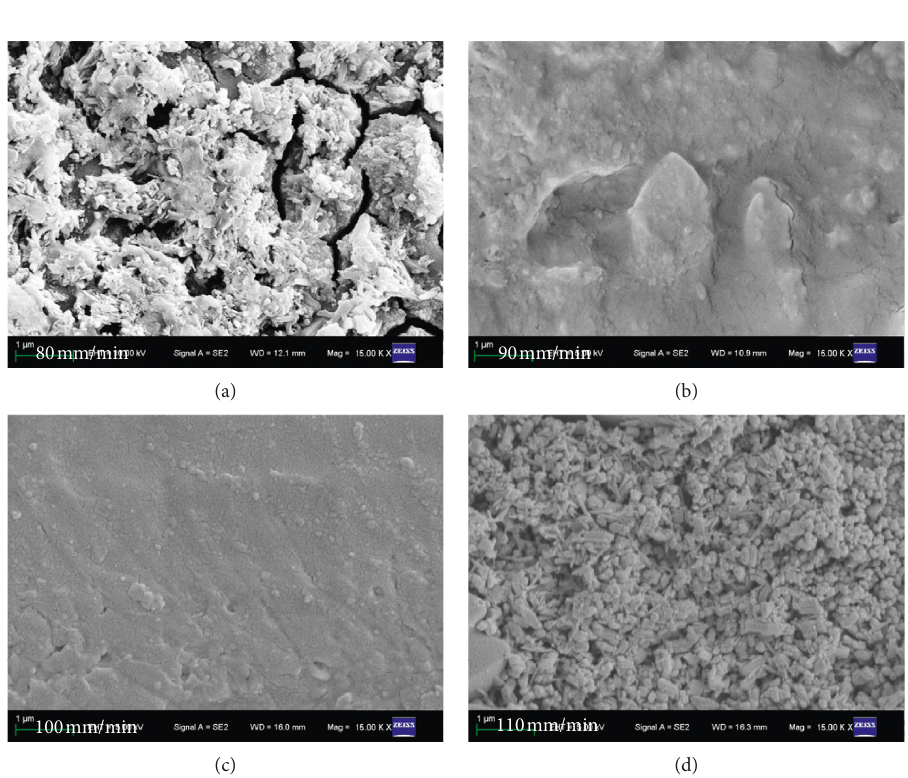
Figure 1: Microstructure of the molten layer at different welding speeds.